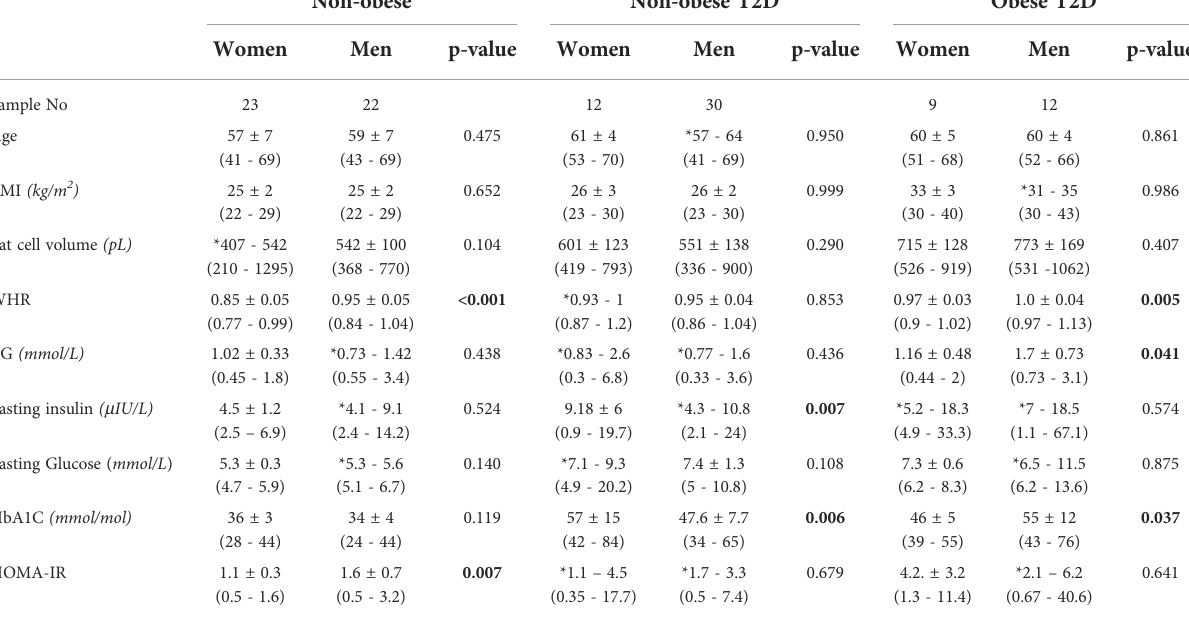
TABLE 1 Clinical parameters of cohort 1.